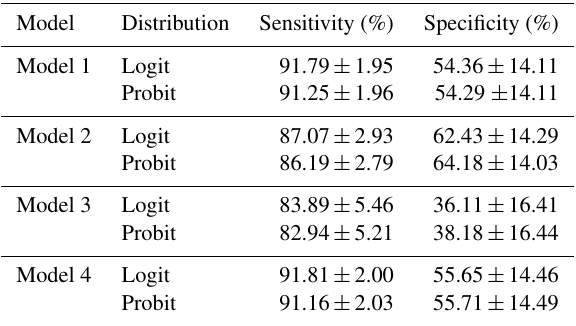
Table 4. Values of the estimators for the probit models. False- positive rate (FPR) and true-positive rate (TPR) were evaluated with a threshold of